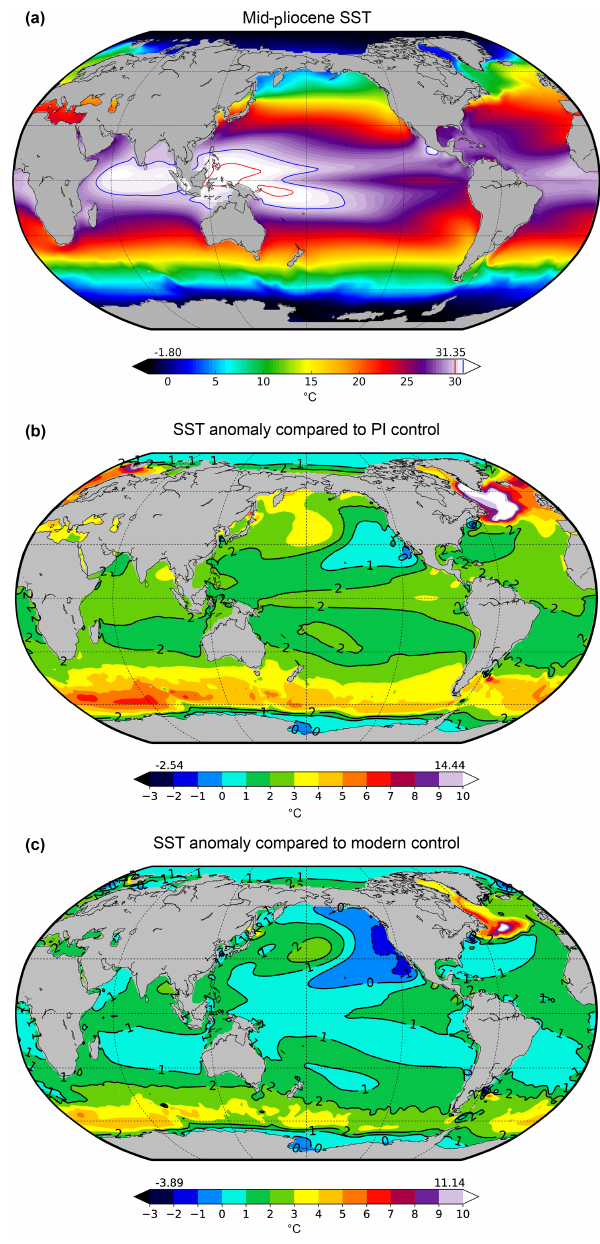
Figure 11. (a) The mid-Pliocene SST from the E oi 400 P simula- tion (cid:104) 2691 , 2720 (cid:105) . The blue and the red contours are for 30 ◦ C and 31 ◦ C, respectively. The SST anomaly with (b) PI control E 280 P (cid:104) 5131 , 5160 (cid:105) and (c) modern control E 400 P (cid:104) 1931 , 1960 (cid:105) . Anomaly is defined as Pliocene minus control. The (cid:104)(cid:105) denotes the range of model years over which the climatology was